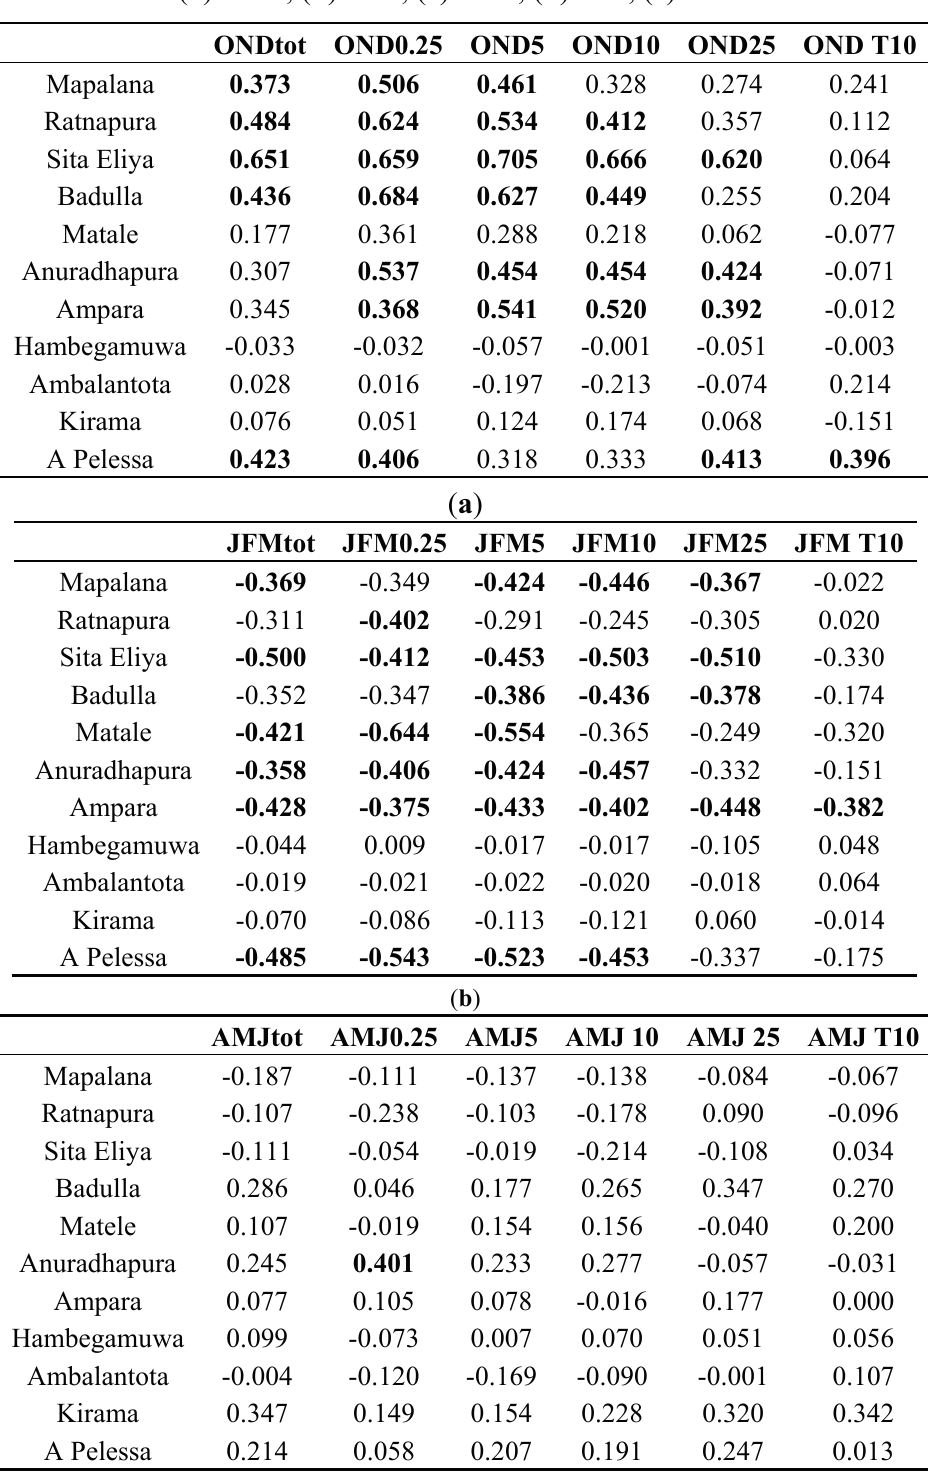
Table 4. Correlations between the SST index for the NINO34 Pacific region and rainfall indices at the 11 stations by season, including M+A. Correlations in bold are significant at the 5% confidence level. Note that, because of some missing rainfall data, the critical value of r may differ between pairs of variables. In most cases n = 31 for which the critical value at p = 0.05 is ±0.349. ( a ) OND; ( b ) JFM; ( c ) AMJ; ( d ) JAS; ( e )